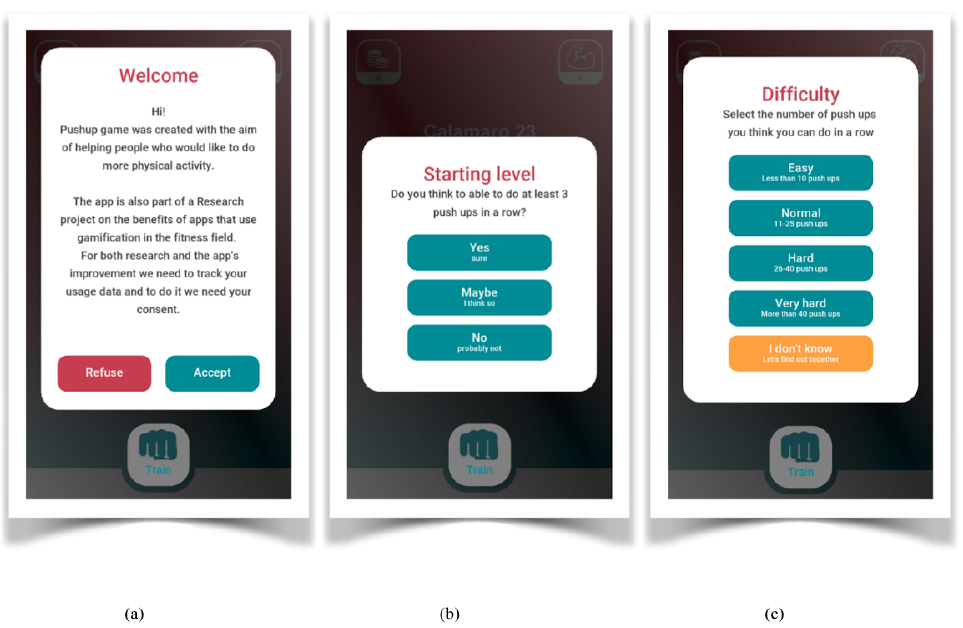
Figure 4. Screenshot of the app: Onboarding. ( a ) the terms and conditions allowing the data collection, ( b ) the question to establish the user’s expertise at performing pushups, ( c ) the question to set the level of difficulty of the training, asking the user how many pushups she/he is able to